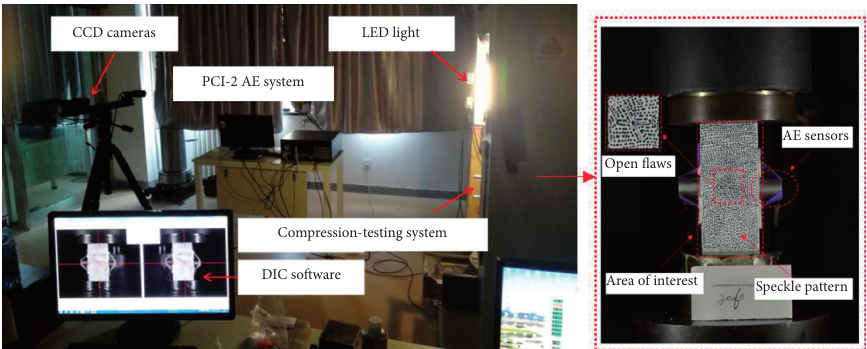
Figure 3: Rock specimens and main equipment.